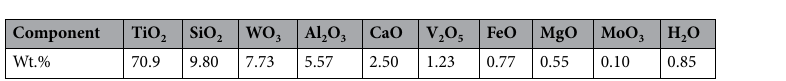
Table 1. Elemental composition of spent SCR catalyst.